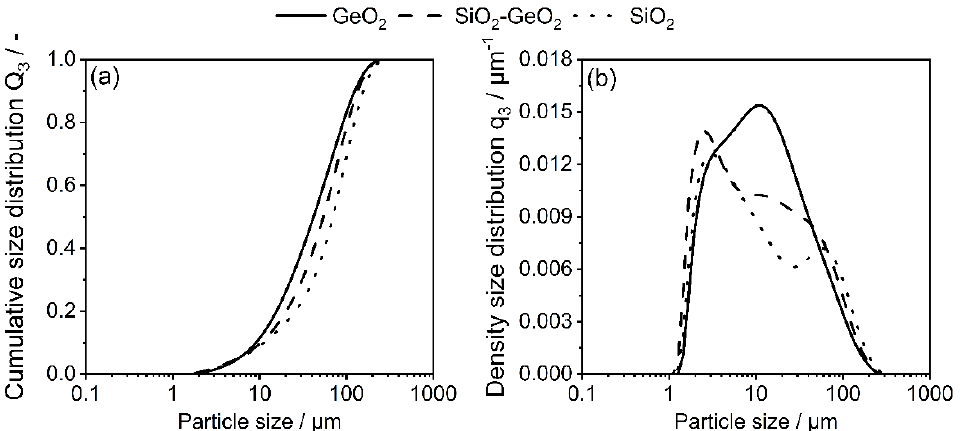
Figure 1. ( a ) Cumulative particle size distribution and ( b ) density particle size distribution of glass. Table 2. Characteristics of the glasses used for comminution experiments.